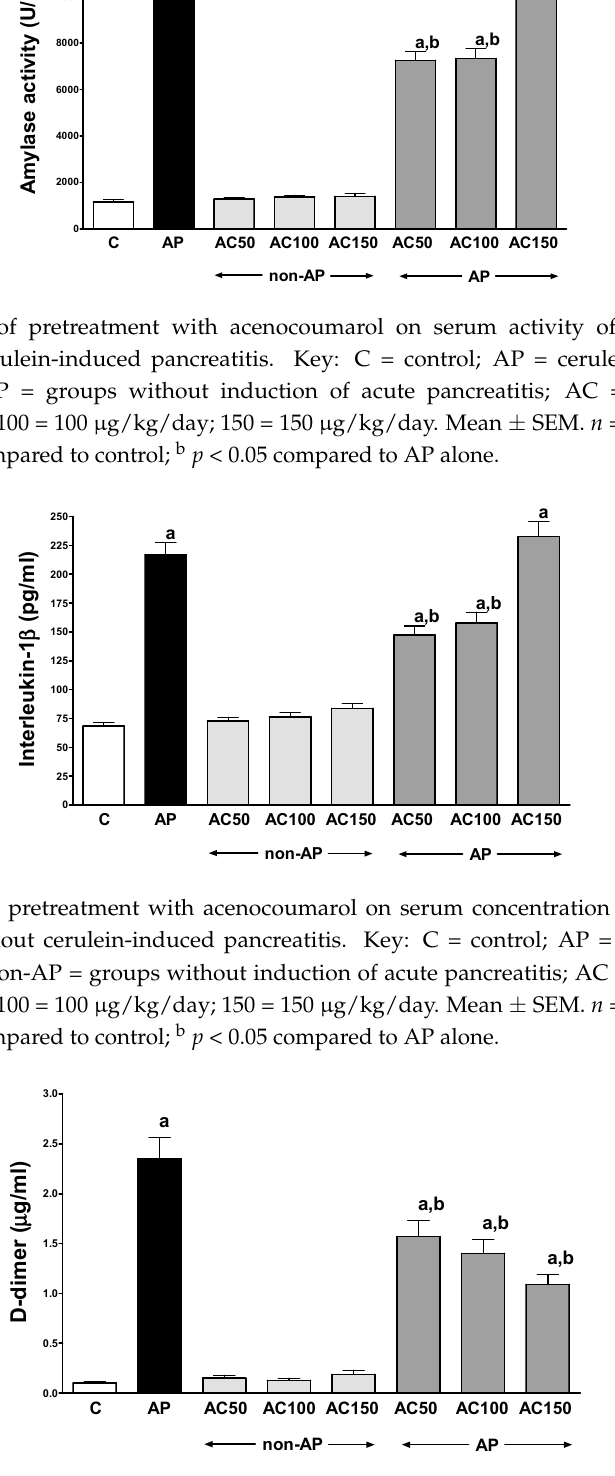
Figure 9. Impact of pretreatment with acenocoumarol on plasma D-Dimer concentration in rats with or without cerulein-induced pancreatitis. Key: C = control; AP = cerulein-induced acute pancreatitis; non-AP = groups without induction of acute pancreatitis; AC = acenocoumarol; 50 = 50 µg/kg/day; 100 = 100 µg/kg/day; 150 = 150 µg/kg/day. Mean ± SEM. n = 10 in each group of rats. a p < 0.05 compared to control; b p < 0.05 compared to AP alone.